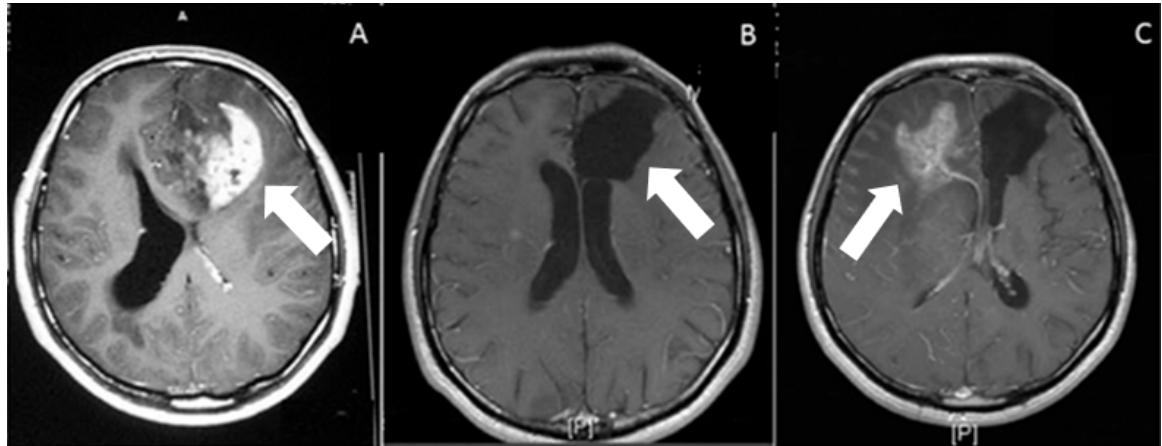
Figure 1. Post gadolinium contrast administration, T1-weighted axial images. ( A ) Preoperative, heterogeneous irregular enhancement, associated with the left frontal-lobe glioblastoma (arrow). ( B ) Postoperative (at 1 month) axial weighted image. On postoperative image, there is no residual enhancement. Arrow shows operation cavity. ( C ) Postoperative (at 18 months) axial weighted image shows recurrence of the tumor (white arrow) on contralateral hemisphere, associated with peripheral edema.